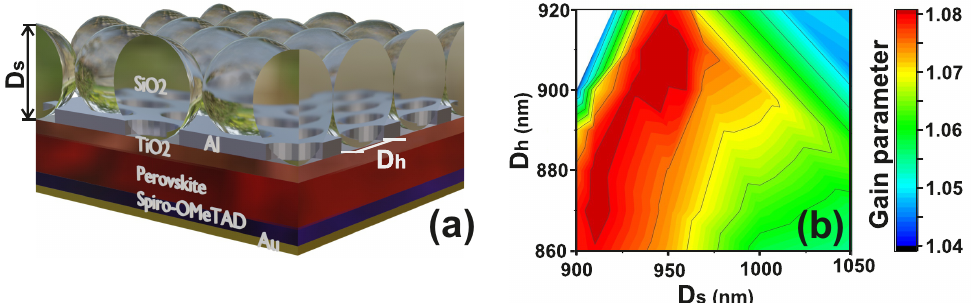
Figure 1. Optimization: ( a ) The scheme of the proposed light-trapping electrode structure. D h is the diameter of holes, D s —diameter of spheres. ( b ) Gain parameter depends on the sphere diameter and hole diameter (calculated for λ = 400–800